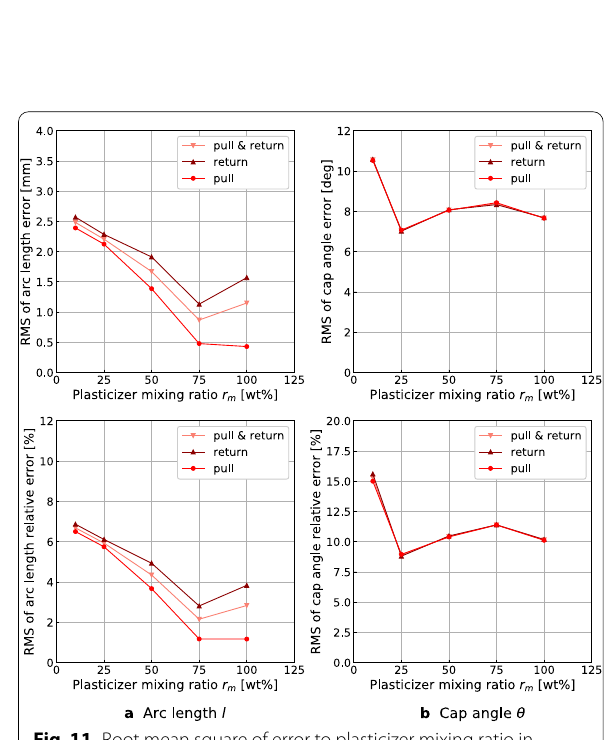
Fig. 11 Root mean square of error to plasticizer mixing ratio in deformation pattern